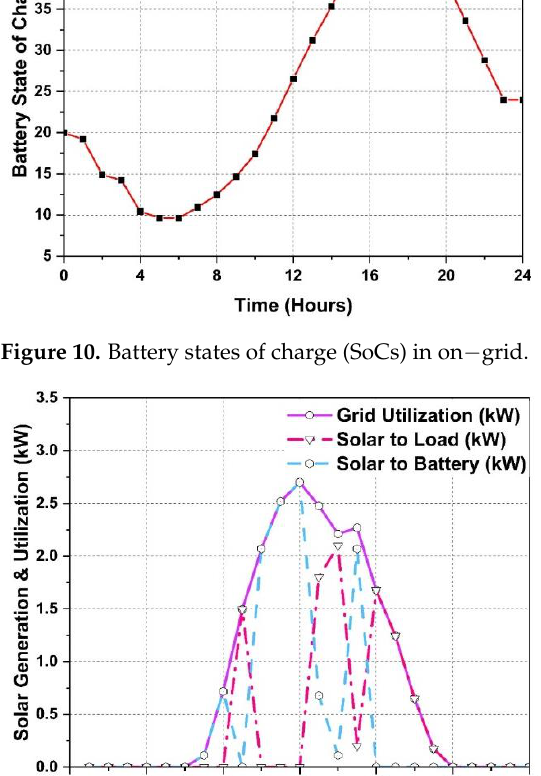
Figure 11. Solar total generation and utilization (on−grid ).